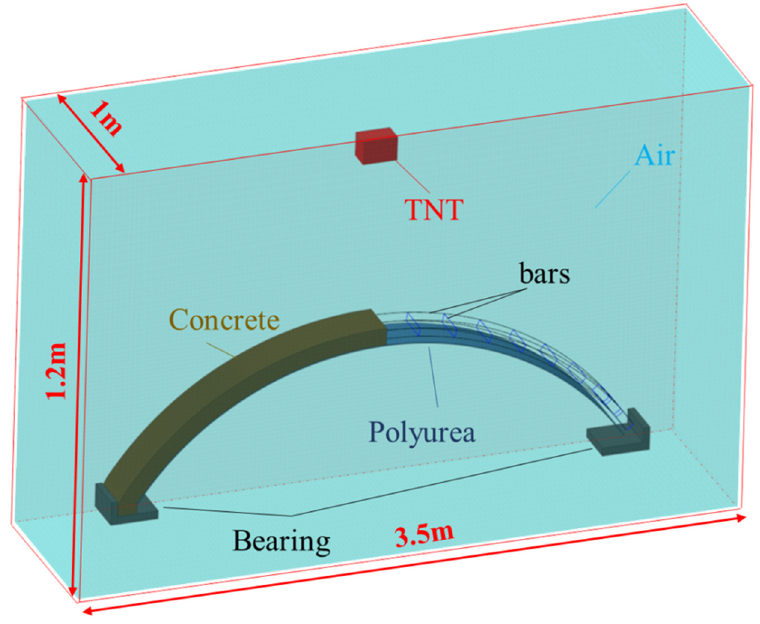
Figure 2. Finite element